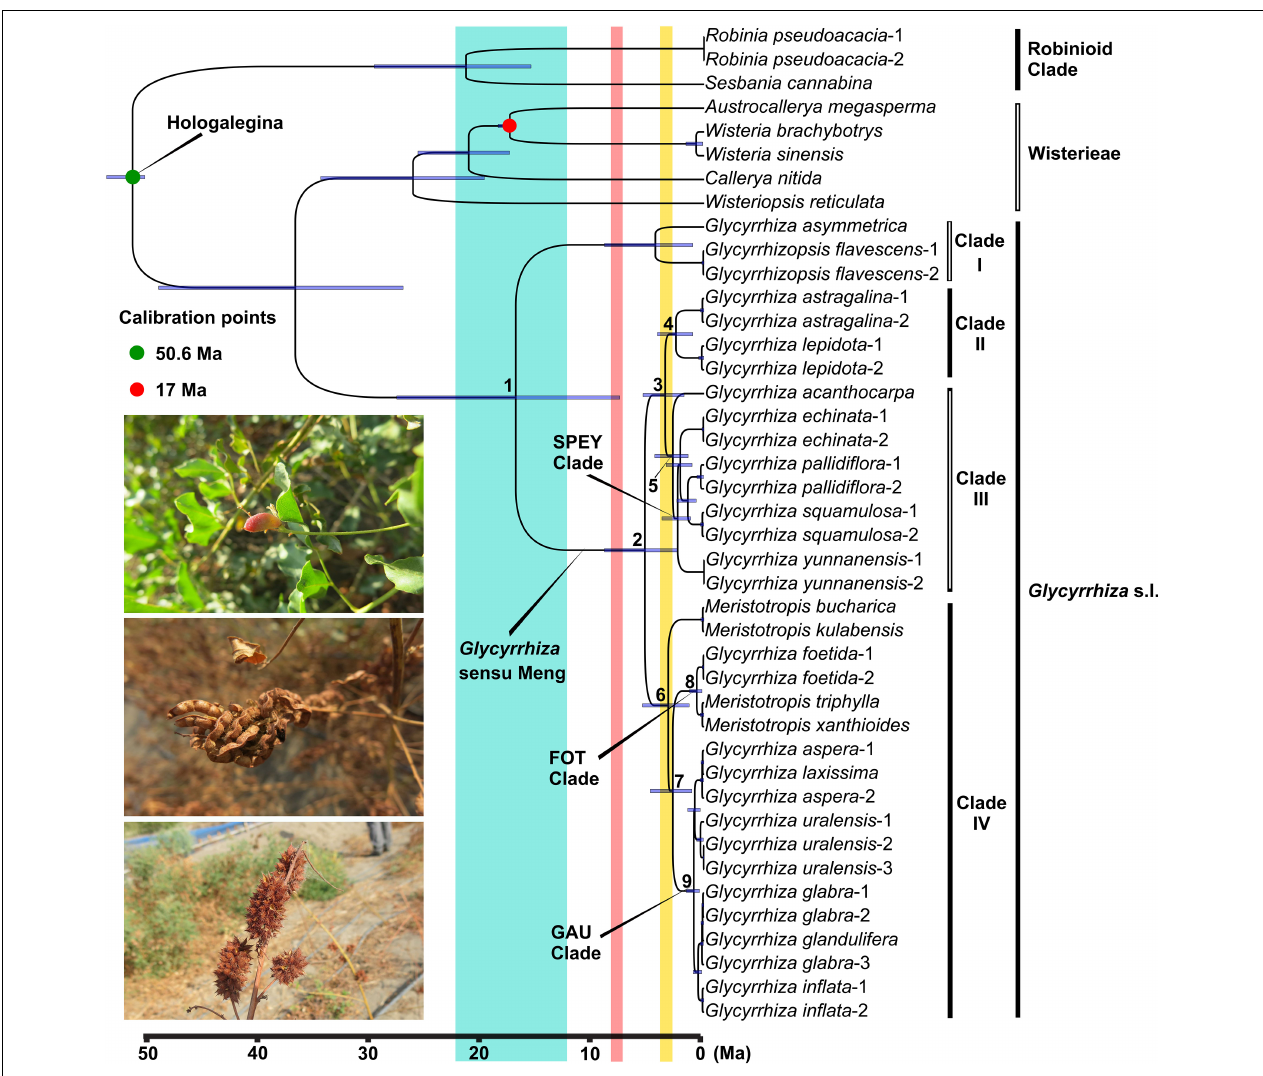
FIGURE 2 | Ultrametric chronogram from BEAST of Glycyrrhiza s.l. and related groups based on chloroplast genome data. Blue bars represent the 95% highest posterior density credibility interval for node ages. Three paleogeological events are indicated with colored vertical rectangles: uplift of the Turkish-Iranian plateau (blue), the third rapid elevation of Qinghai-Tibetan Plateau (QTP; pink), and the fourth rapid upraising of QTP (yellow). The three photos show the fruits of Glycyrrhiza inflata (upper) , G. uralensis (middle) , and G. pallidiflora (lower) , respectively.